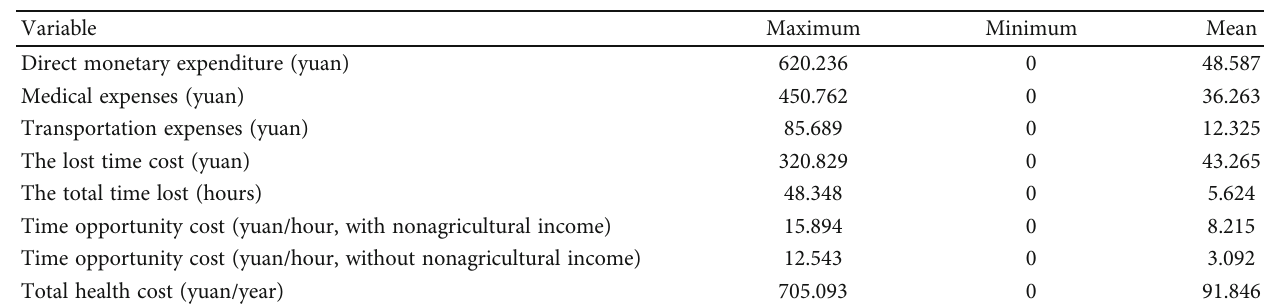
Table 2: Farmers ’ health costs of pesticide